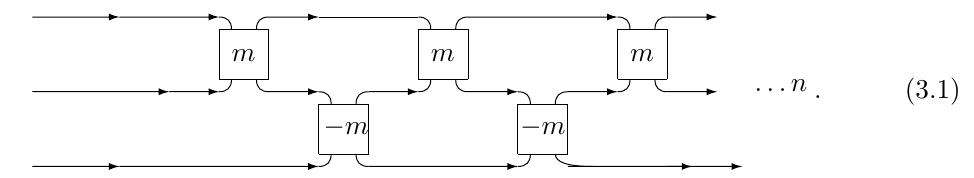
ˆ W 3 (3 , 2) = 12a1288